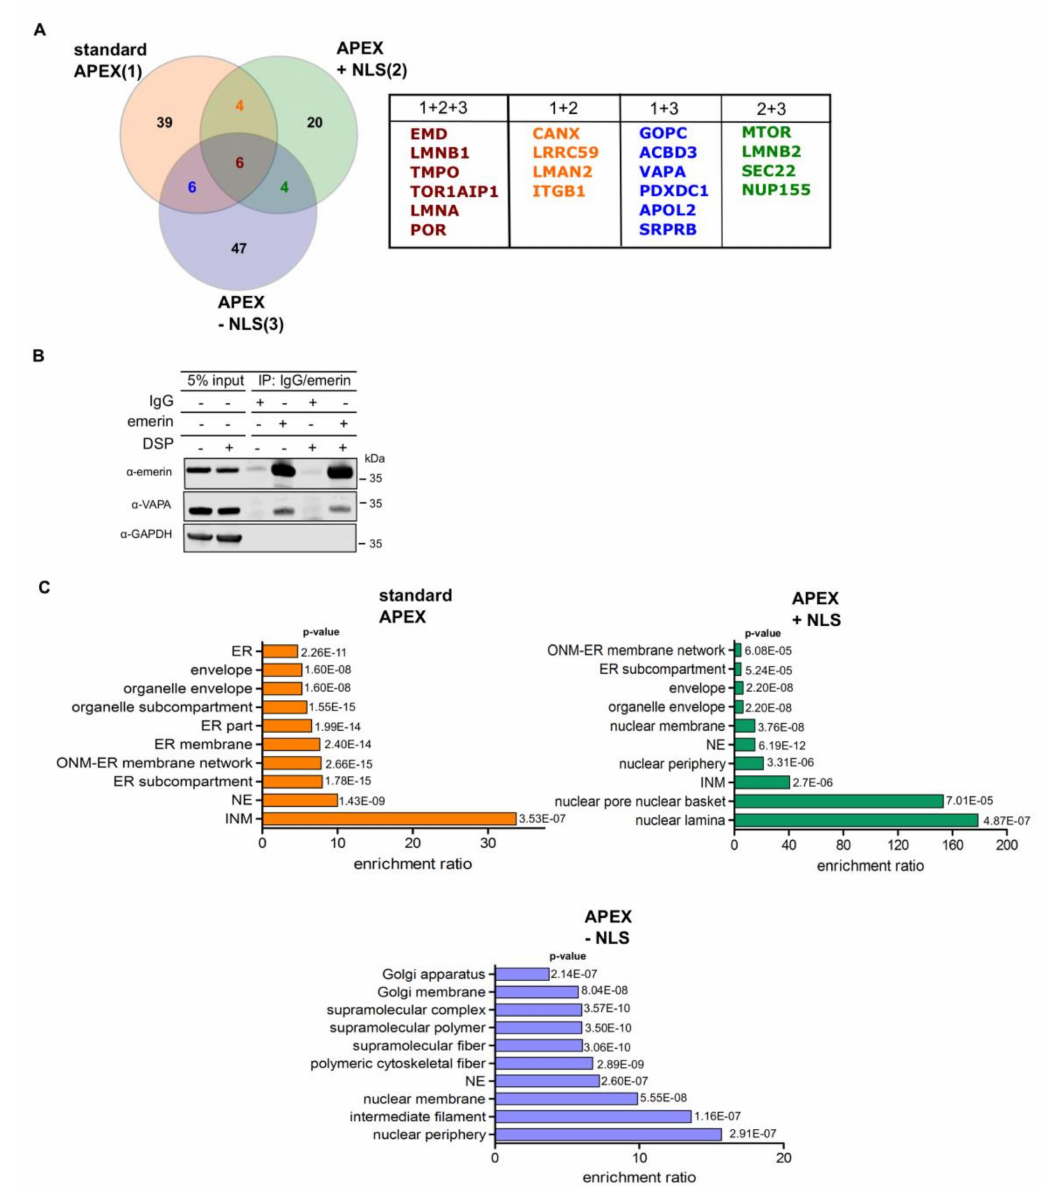
Figure 6. ( A ) Venn-diagram of proteins identified to be in close proximity to emerin in three di ff erent approaches: “standard APEX (1)” (see Figures 1 and 2), “APEX plus NLS (2)” (APEX2-dGFP-NLS-FKBP12; see Figure 3, Figure 4) and “APEX minus NLS (3)” (FKBP12-GFP-APEX2; see Figure 5). For the analysis, proteins were included that were identified as significant hits at least once. See also Table S4 for a list of relevant proteins. ( B ) HeLa cells were treated with or without the crosslinking reagent DSP and cellular lysates were subjected to co-immunoprecipitation reactions using mouse anti-emerin antibodies or IgG as a control. Precipitated proteins as well as 5% of the original lysate were analyzed by SDS-PAGE followed by Western blotting. For detection, mouse-anti-emerin, mouse-anti-VAPA and rabbit-anti-GAPDH were used. ( C ) Gene Ontology cellular compartment classification of all significant proteins (Table S4) identified in three di ff erent approaches as shown in ( A